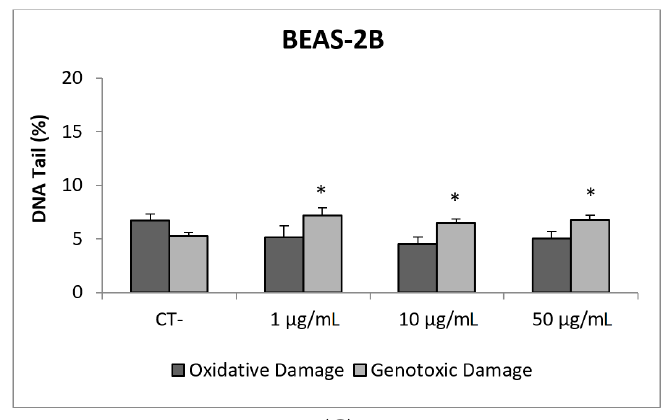
Figure 6. Results from the SiO 2 NPs (NM203), on A549 and BEAS-2B cells. ( A ) Toxicity curves for both cell lines. ( B ) Genotoxicity results obtained in A549 cells. ( C ) Genotoxicity results obtained in BEAS-2B cells. Genotoxicity data are plotted as mean ± SEM of two independent experiments. * p ≤ 0.05, *** p ≤ 0.001 (one way-ANOVA). CT, control.